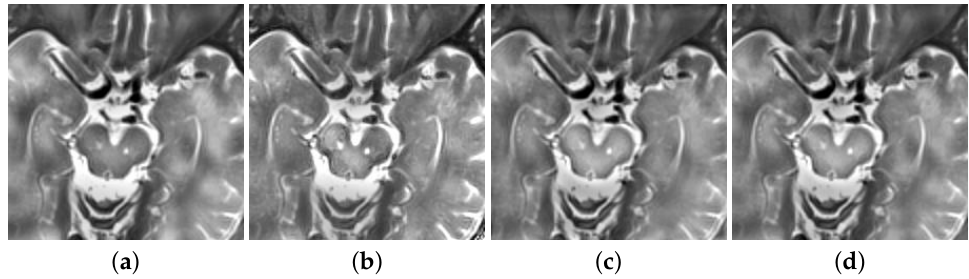
Figure 12. ( a ) Fusion results of Laplacian pyramid (LP). ( b ) Fusion results of ratio of low-pass pyramid (RP). ( c ) Fusion results of curvelet transform (CVT). ( d ) Fusion results of nonsubsampled contourlet transform